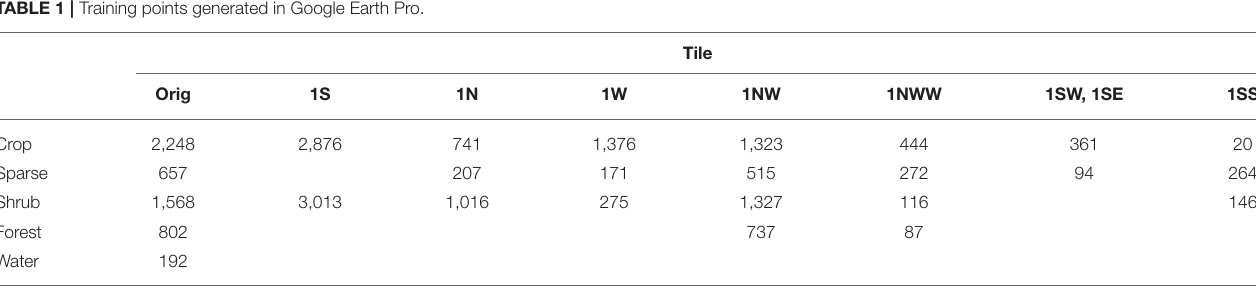
TABLE 1 | Training points generated in Google Earth